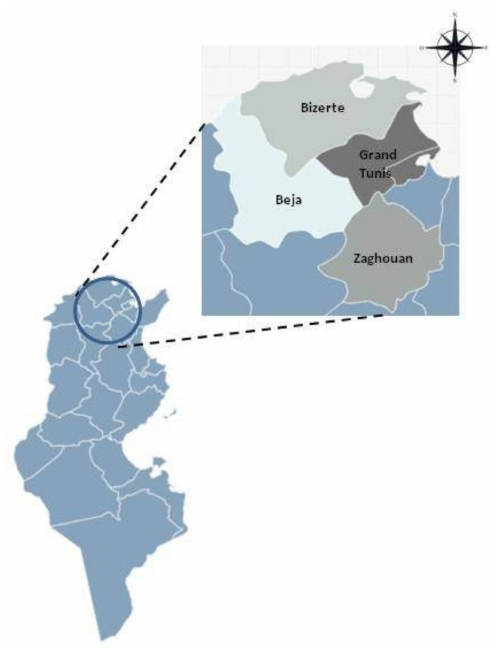
Figure 1. Location of the study area in